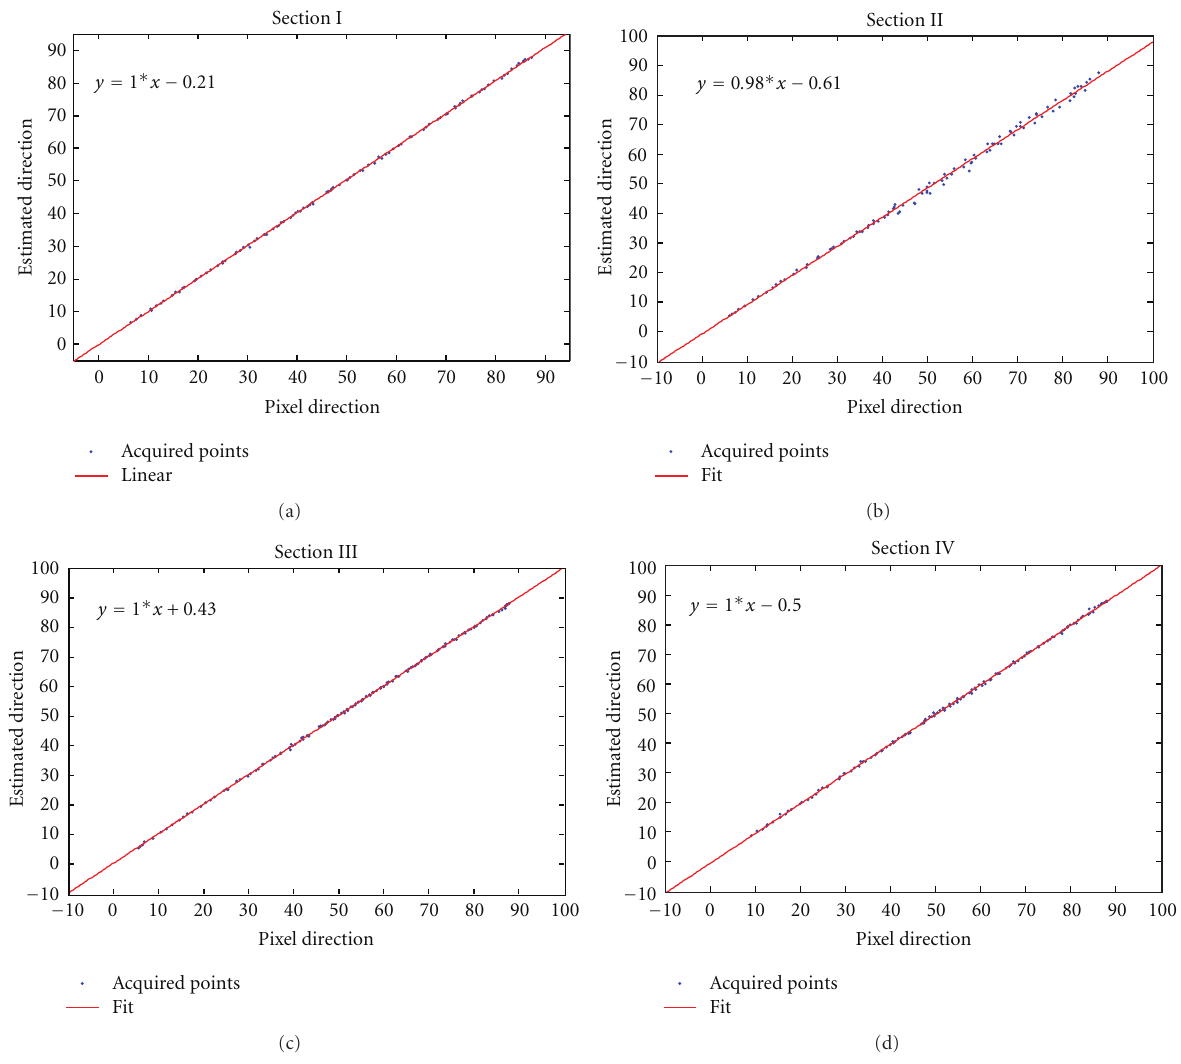
Figure 8: Polynomial fitting for direction estimation for sections I, II, III, and